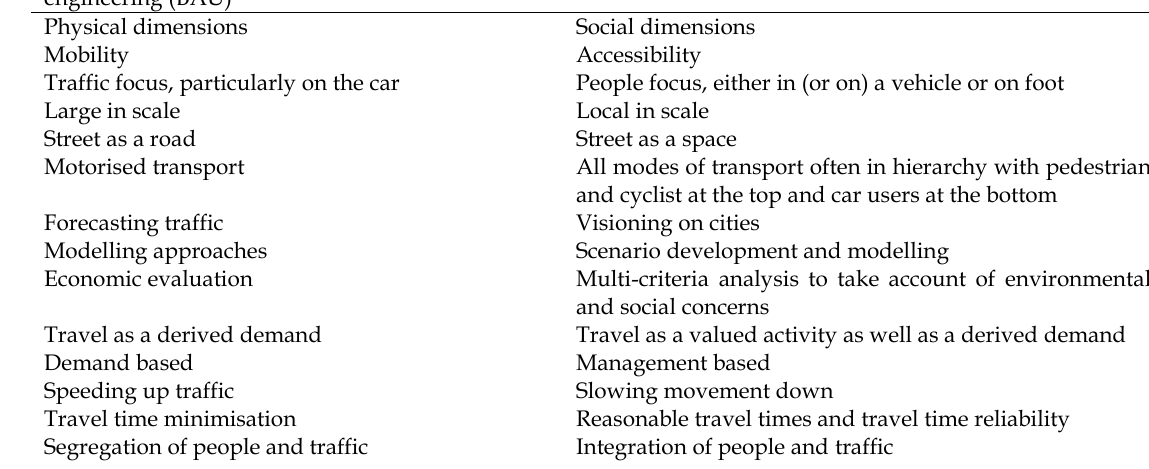
Two transport planning approaches: Business-as-usual (BAU) and Sustainable Development (SD) (Banister, 2008) Conventional approach – Transport planning